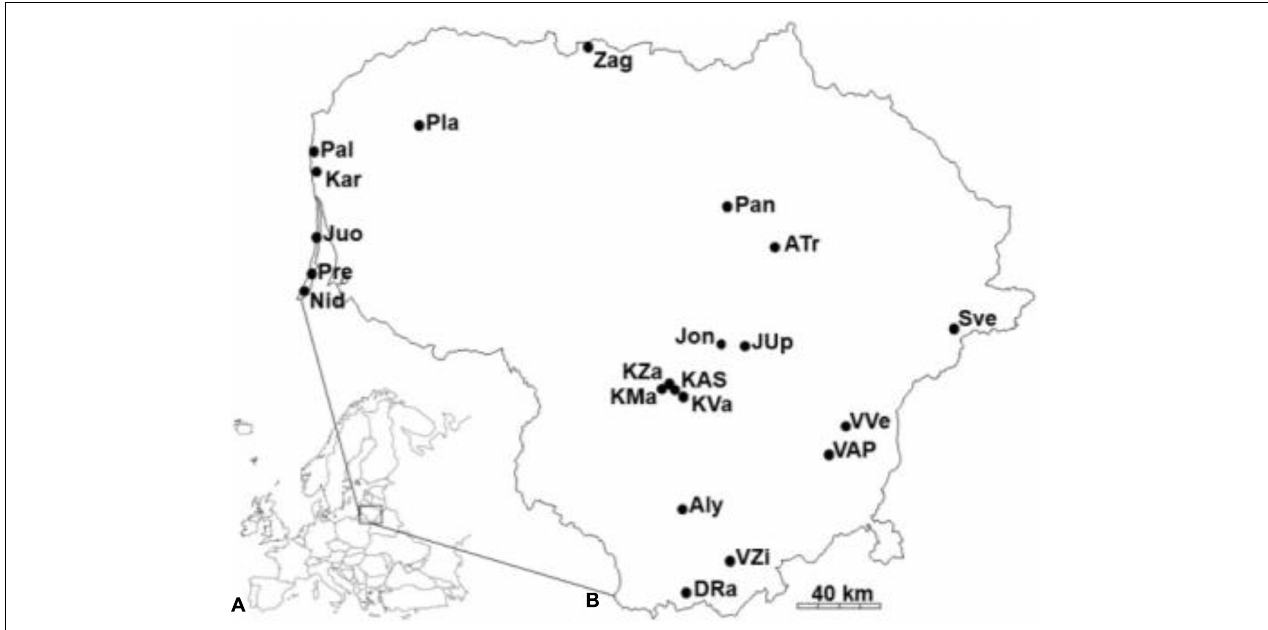
FIGURE 1 | Location of Lithuania (A) , and sites with Impatiens parviflora in the country (B) . Populations are named by three letters.